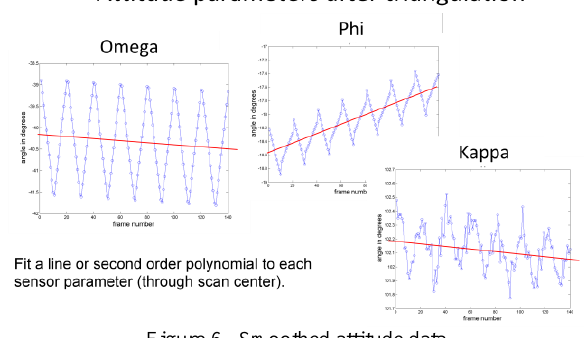
Figure 6. Smoothed attitude